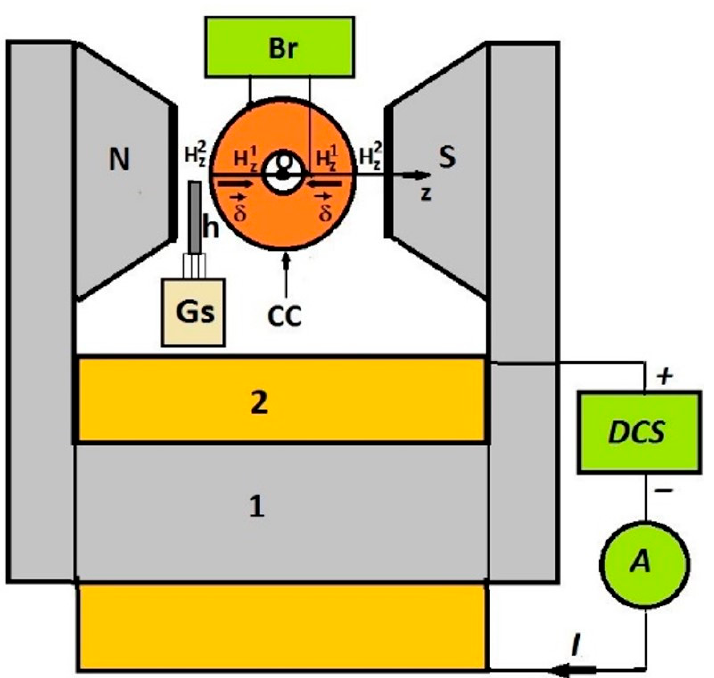
Figure 6. Experimental setup (overall configuration) consisting of an electromagnet (with the follow- ing components: 1—magnetic yoke; 2—coil; N and S—magnetic poles); CC—cylindrical capacitor; Br—RLC bridge; Gs—Gaussmeter; h—Hall probe; DCS—direct current source; A—direct current ammeter; I—electric current intensity; Oz—coordinate axis; H 1 z and H 2 z —magnetic field intensities; → δ —vector of the magnetic field intensity